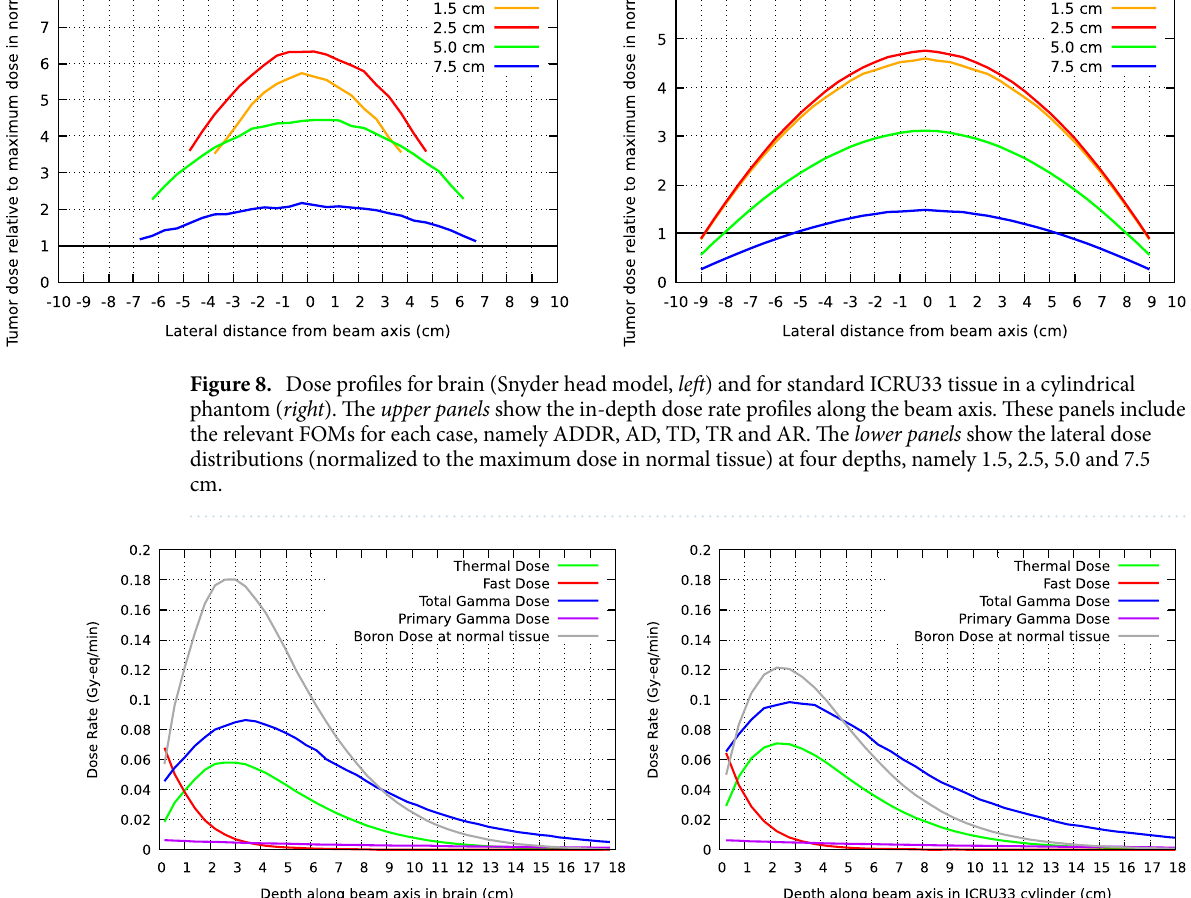
Figure 9. Dose rate components at the brain tissue for a model irradiation of the Snyder phantom ( left panel ) and for the ICRU33 standard tissue cylinder ( right panel ). Thermal, fast and total gamma dose rates are given. The primary gamma dose, directly impinging to the phantom from the beam is also shown separately. This remarks the low gamma contamination of the designed